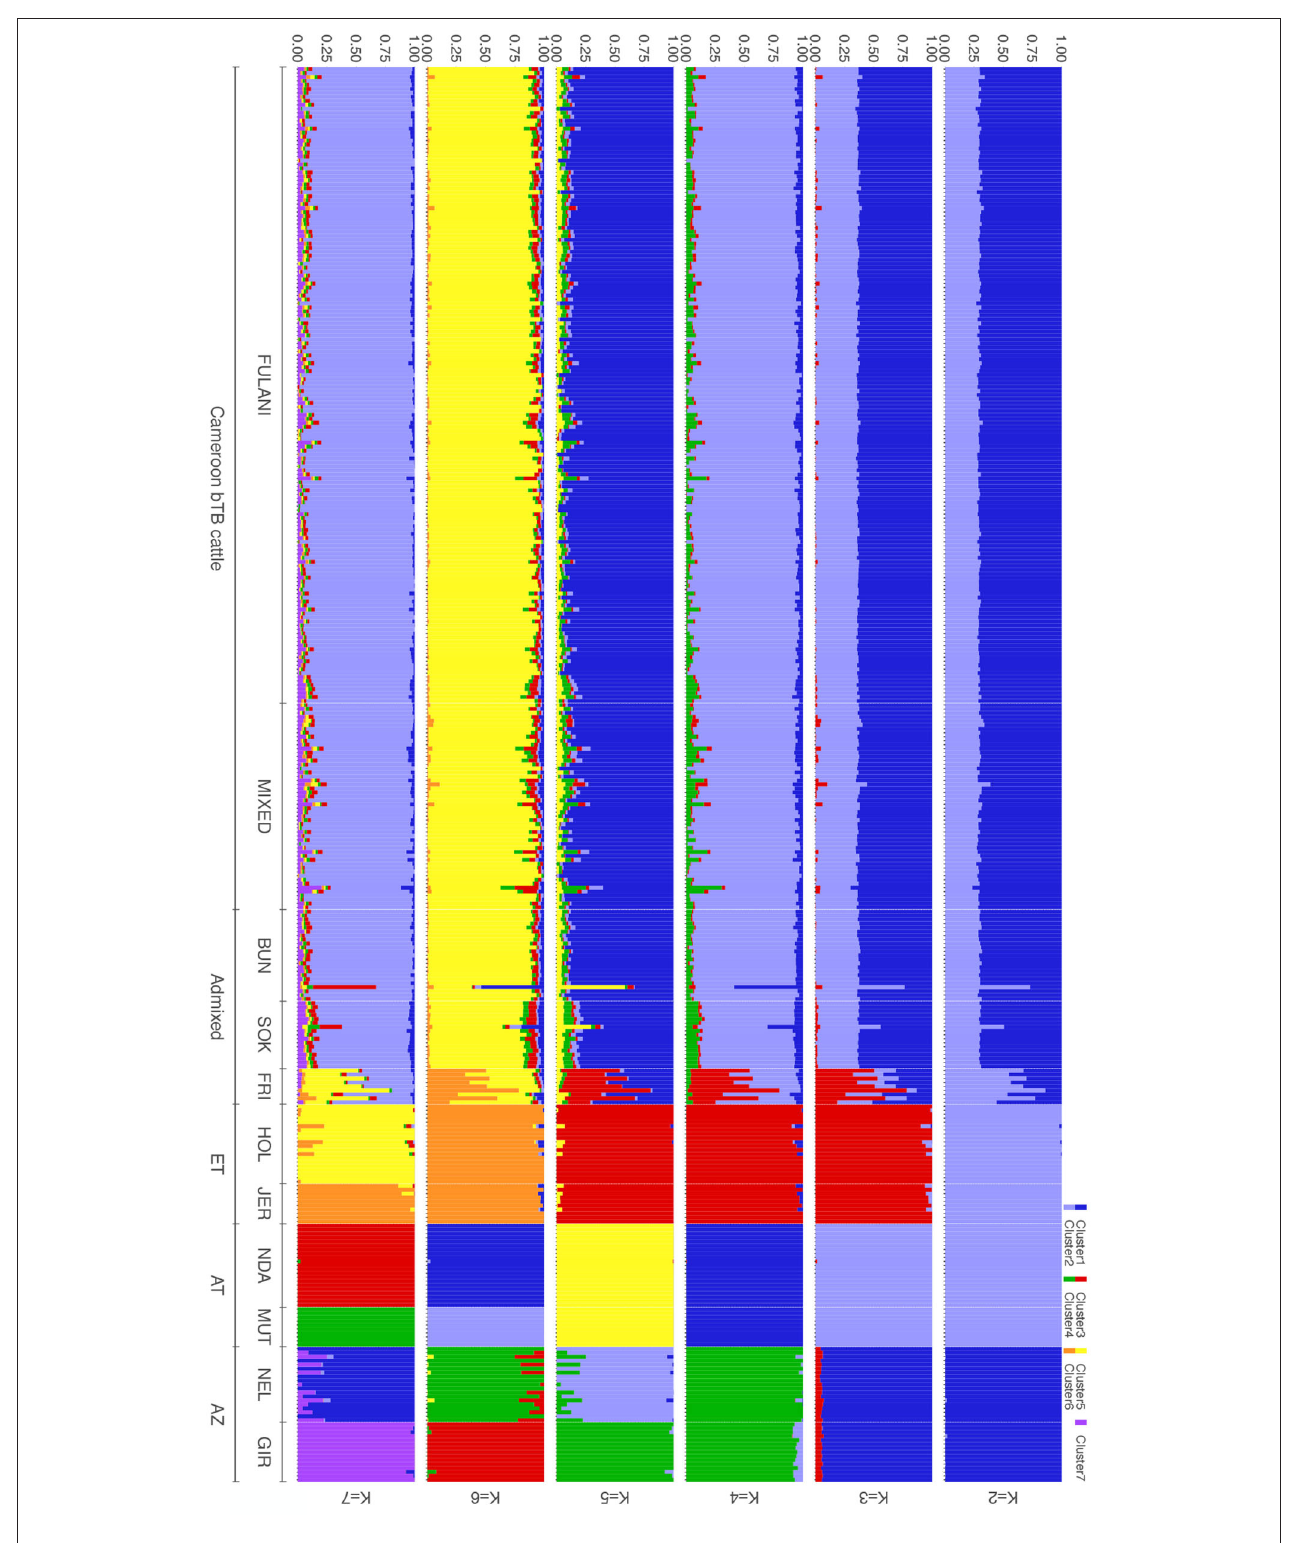
FIGURE 4 | Admixture bar plots for the proportion of genetic membership to each ancestry assuming ( K = 2 to K = 7) ancestral populations. Each animal is represented by a vertical line divided into K colors, indicating the likelihood of the animal’s genome belonging to an ancestral population.